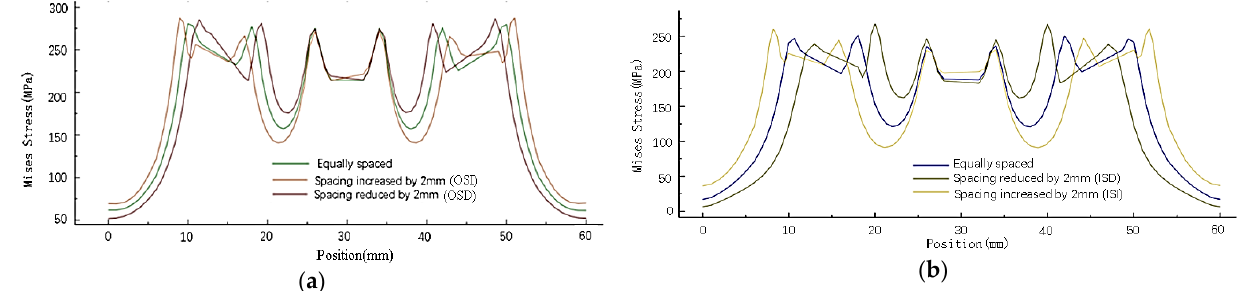
Figure 13. Stress distribution of the connector after stretching under changing the spacing of rivets: ( a ) Stress distribution